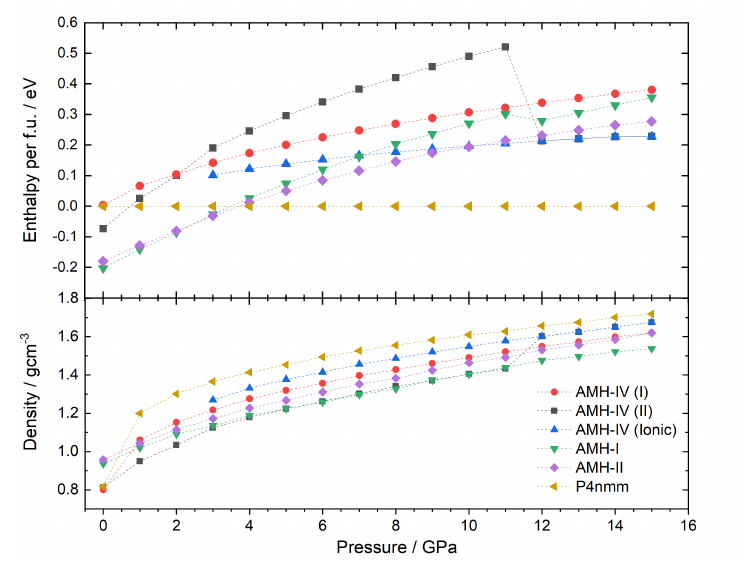
Figure 5. Enthalpy per formula unit and densities of the ammonia monohydrate phases AMH–I, AMH–II, Griffiths’ P 4/ nmm phase and the P2 1 / c structures of AMH–IV as a function of pressure. AMH–IV (II) spontaneously ionises at 12 GPa and changes its unit cell.